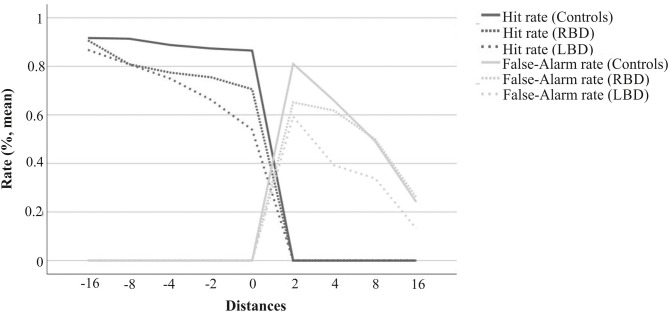
Hit and False-Alarm rates for LBD patients, RBD patients and age-matched healthy controls. The figure displays an overview of changes in Hit- and False-Alarm rates for the different distances across tracks. The value “0” reflects a trial with an object presented at the individually-defined maximum reachable distance. Distance-values represent deviations (cm) from the individual's maximum reachable target. Objects presented at positions with negative distance-values were located within the participant's actual reach (correct response: yes), and those with positive distance-values were located out of reach (correct response: no). The graphs display a typical distribution with higher Hit and lower False-Alarm rates for distances that are considerable further away from the physical constraints. Conversely, judgment performance for distances closer to the maximum reach (0) decreased.